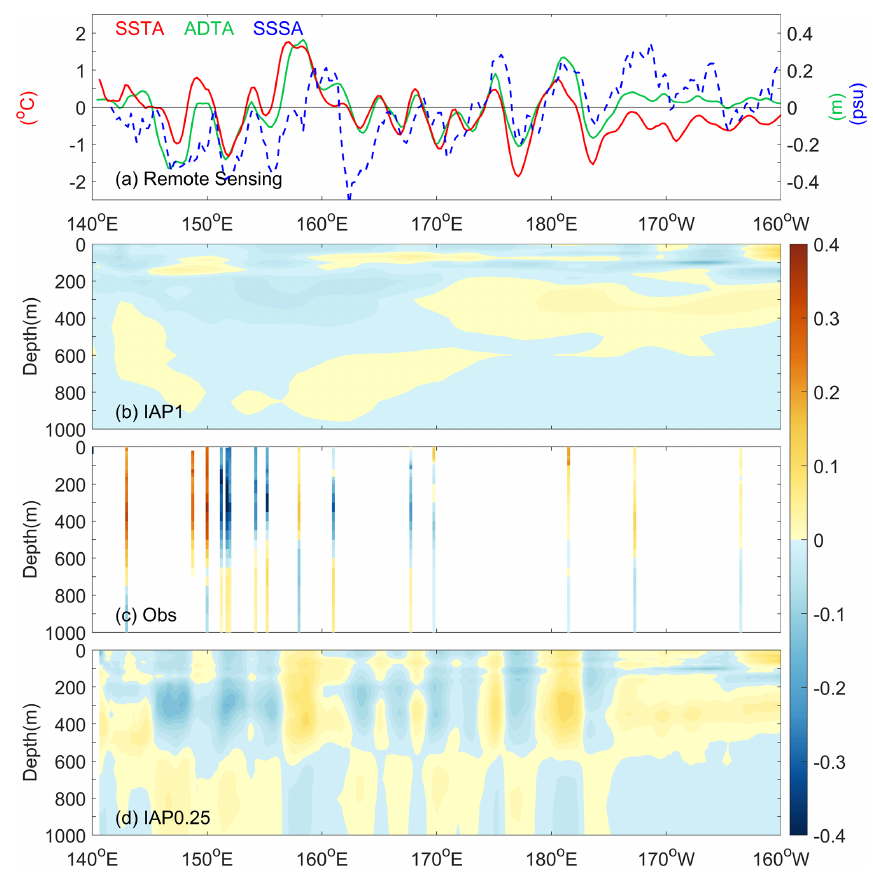
Figure 8. As in Fig. 7 but for the Kuroshio and its extension region along 35.375 ◦ N in January